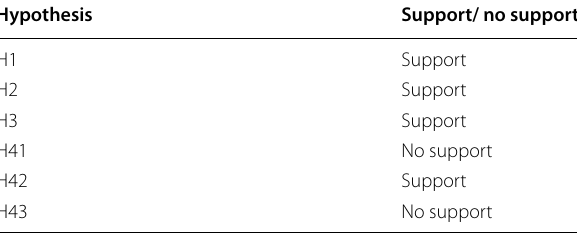
Table 7 Results of